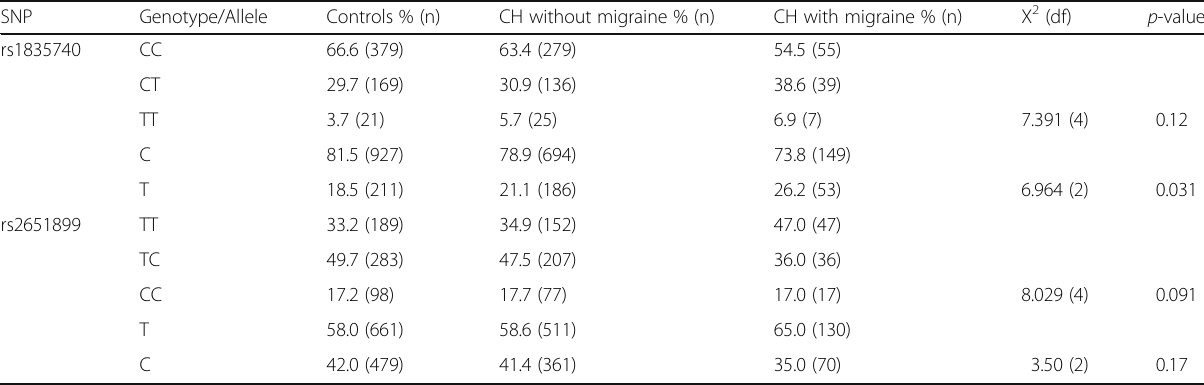
Table 2 Results from the genotype and allele analysis in patients with and without migraine SNP